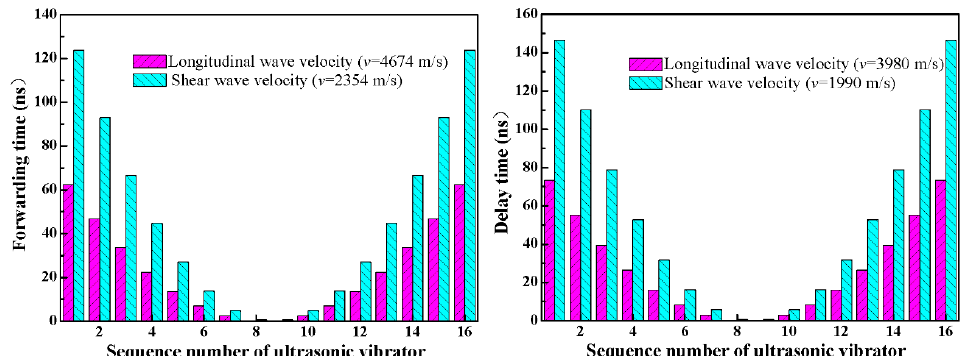
Figure 7. Advance time of each ultrasonic vibrator on the copper plate and frost layer.